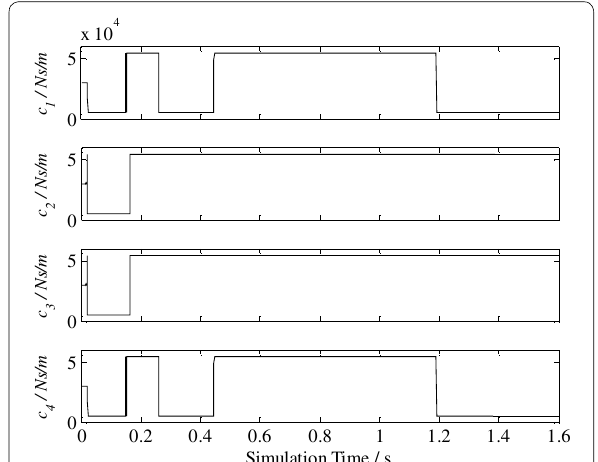
Figure 6 Damping coefficient of adaptive buffer